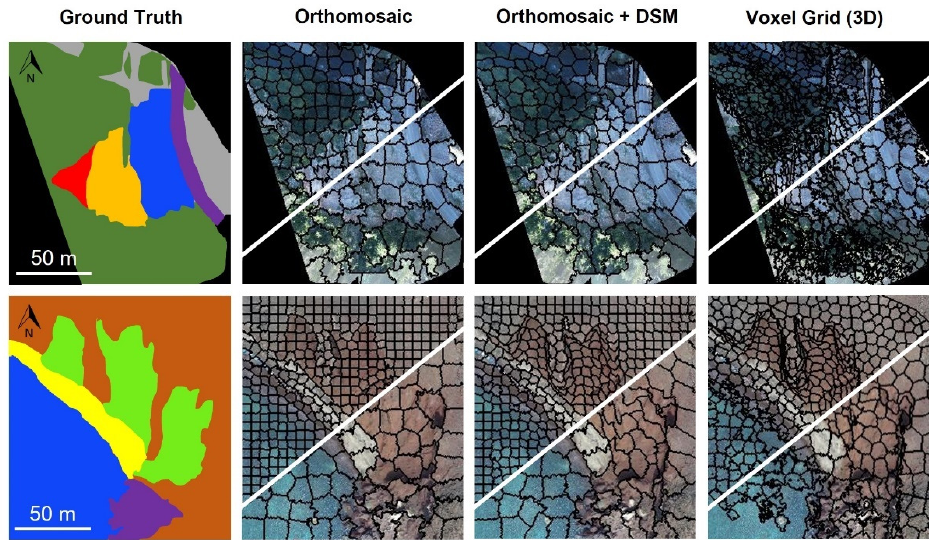
Figure 5. Examples of superpixel/supervoxel output. From left to right: the ground truth annotation, 2D, 2.5D, and 3D input model. Each is shown with two different superpixel/supervoxel resolutions. In the Proussos case, above, elements such as the scarp (red), depletion zone (yellow), accumulation zone (blue), road (purple), and non-affected area (green) are delineated, while in the Red Beach case, below, the annotated elements include landslide areas (green), rockfall deposits (purple), the beach (yellow), waterbody (blue), and the non-affected area (brown).